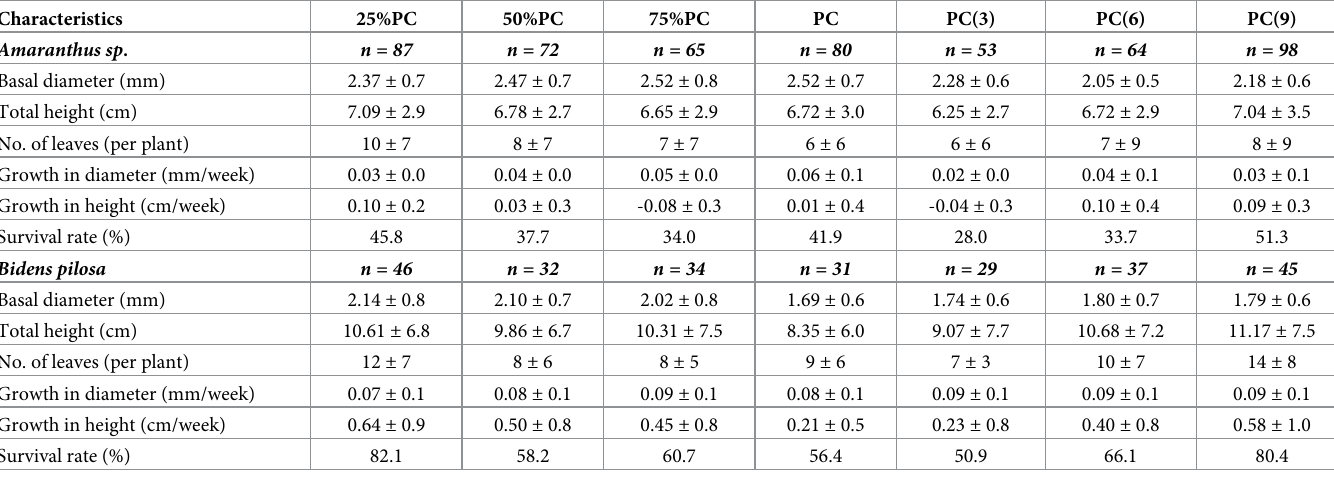
Table 2. Mean values of the considered characteristics ( ± SD)of the study species between water treatments, after first harvest.